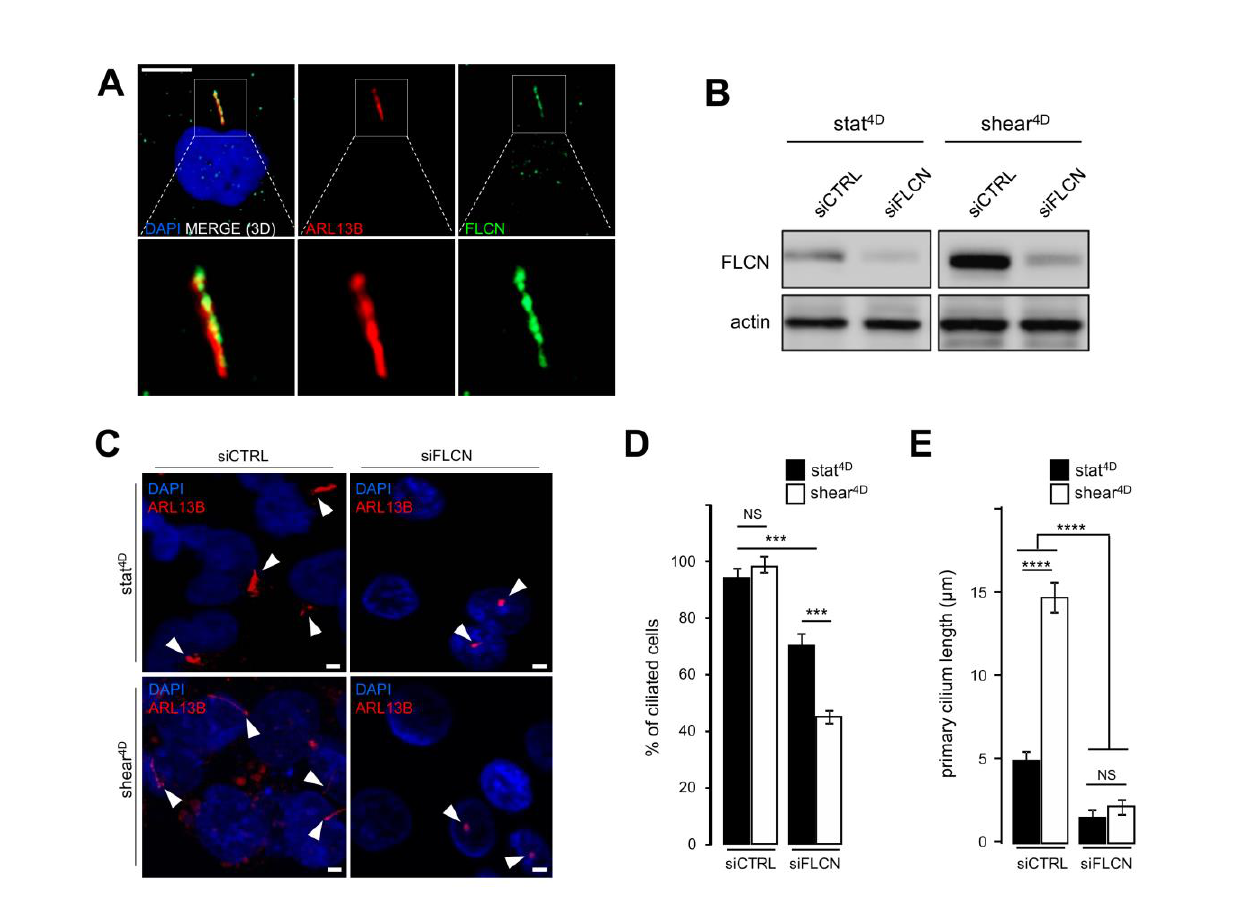
FIGURE 2: FLCN is associated with primary cilium and ciliogenesis . (A) HK2 cells grown for 9 6h in static conditions were fixed with methanol, labeled with DAPI, immunostained for FLCN, ARL13B (to reveal primary cilium) and then analyzed by fluorescence microscopy. (B-E) HK2 cells were transfected either with siRNA targeting FLCN (siFLCN) or control siRNA (siCTRL). 72 h later they were subjected to 4 days fluid flow (shear 4D) or not (static 4D). (B) FLCN downregulation by siRNA efficiency was verified by western blot. (C) Cells were fixed with methanol, labeled with DAPI, immunostained for ARL13B (to reveal primary cilium) and then analyzed by fluorescence microscopy. (D, E) Quantification of ciliat- ed cells number and cilia length fro m experiments shown in (C). Scale bars in (A) = 10μm and (C) = OPEN ACCESS | www.cell-stress.com 102 Cell Stress | MARCH 2019 | Vol. 3 No. 3